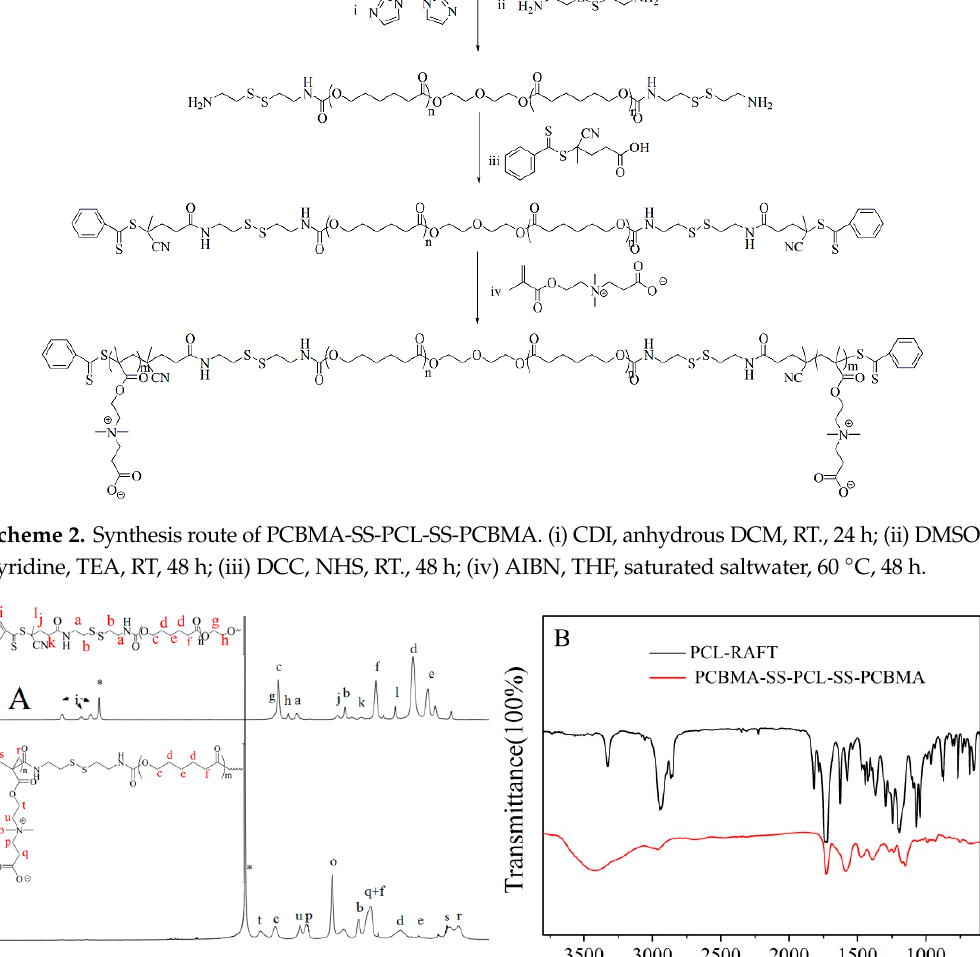
Figure 2. Intensity ratios of I 375 /I 368 of pyrene as a function of copolymer concentrations ( A ); Hydrodynamic diameter distribution f ( D h ) ( B ) and TEM image of PCBMA-SS-PCL-SS-PCBMA micelles (inserted) formed in PB buffer (7.4). As the PCBMA shell links with the PCL core by disulfide bonds, polymer micelles may possess high antifouling and redox responsive properties. Serum stability of polymer micelle was first investigated by DLS analysis after incubation with PB containing 10% BSA and 50% FBS solution. As shown in Figure 3A, no significant changes in size were observed even after incubation for 72 h,